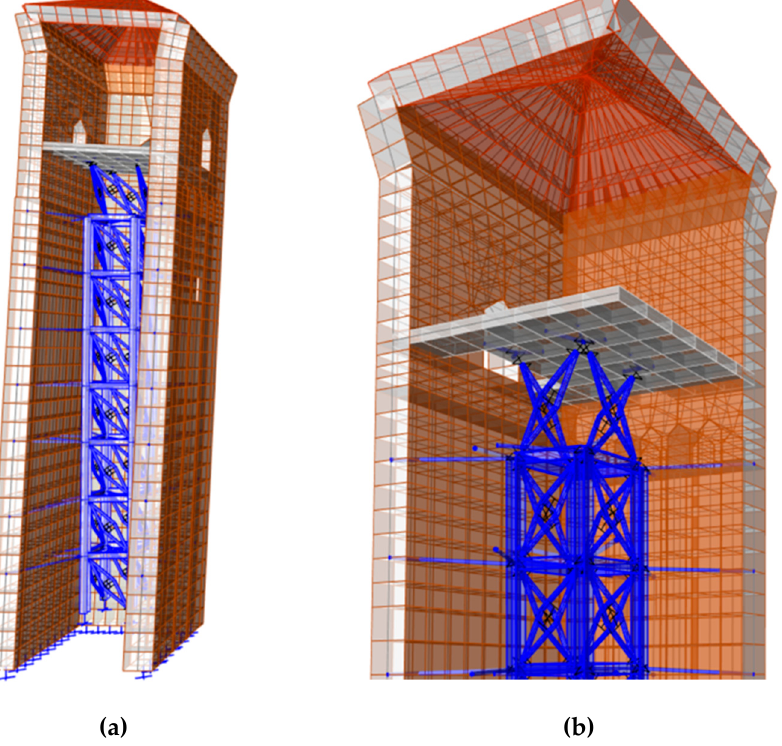
Figure 19. Inner and outer tower finite element model: ( a ) global view; ( b ) detail of the steel tower connection to the reinforced concrete slab.